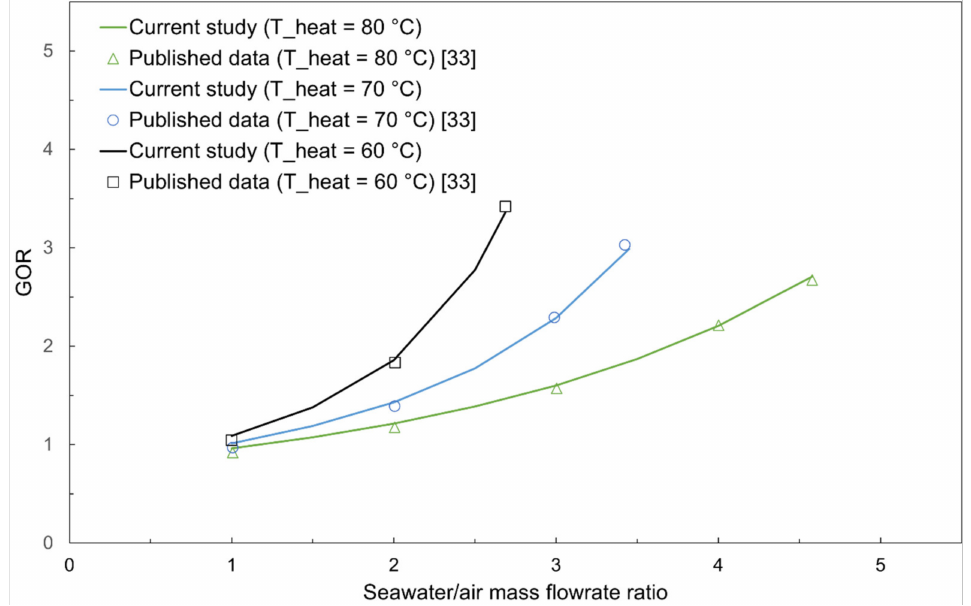
Figure 4. HDH model verification with published data [34].